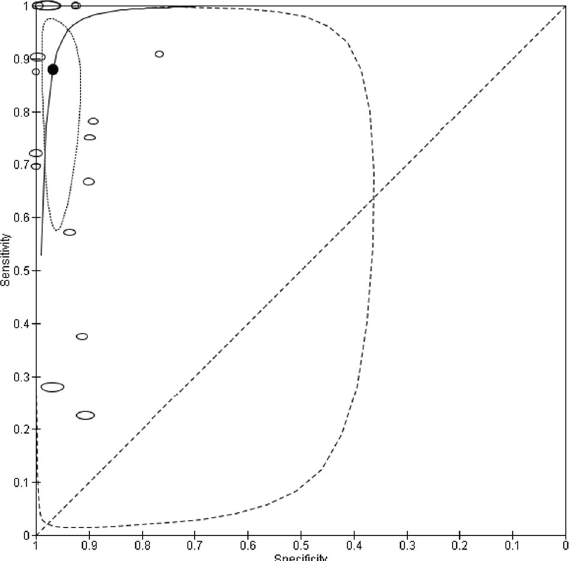
Fig. 5 Random effects bivariate summary receiver operator characteristic curve of telemedicine for the diagnosis of surgical site infection. Summary curve and point estimates display high levels of accuracy. Elliptical data points represent weight sensitivity- speci fi city trade-off for each study. The summary point is expressed in the summary curve with dotted line 95% con fi dence region and dashed line 95% prediction